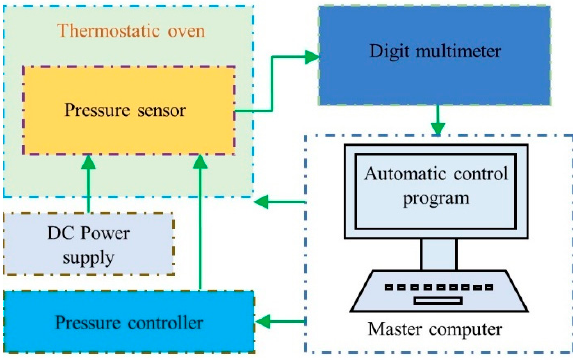
Figure 7. Sensor characterization system.